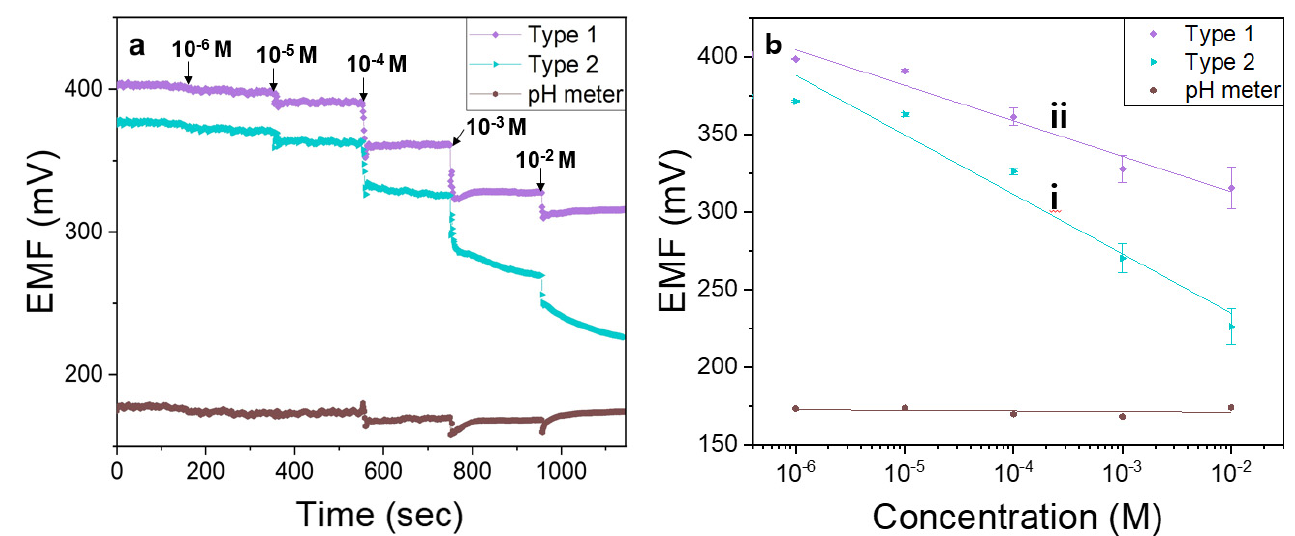
Figure 4. Calibration curve of two types of ISEs: ( a ) EMF response from 10 − 6 to 10 − 2 M KH 2 PO 4 and ( b ) plot of EMF versus logarithmic concentration.